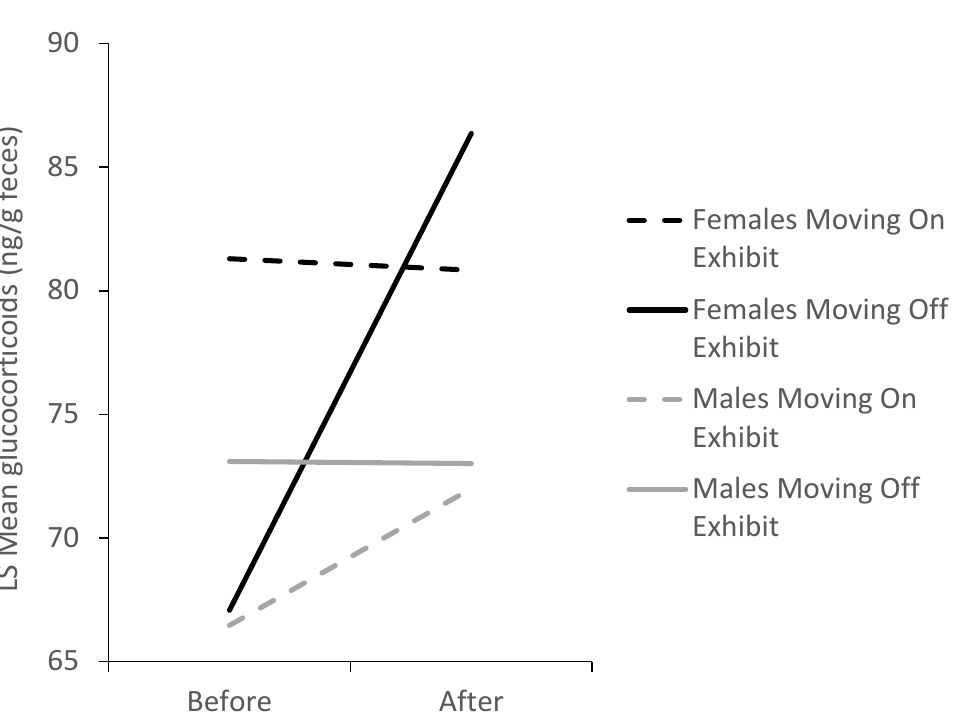
Figure 5. Changes in mean fecal glucocorticoid concentrations (N gpigs = 16, N samples = 117) in male and female guinea pigs before and after moves between on-exhibit and off-exhibit habitats. Female glucocorticoids increased significantly the week after moving to the off-exhibit habitat ( p < 0.05); there were no other significant differences.